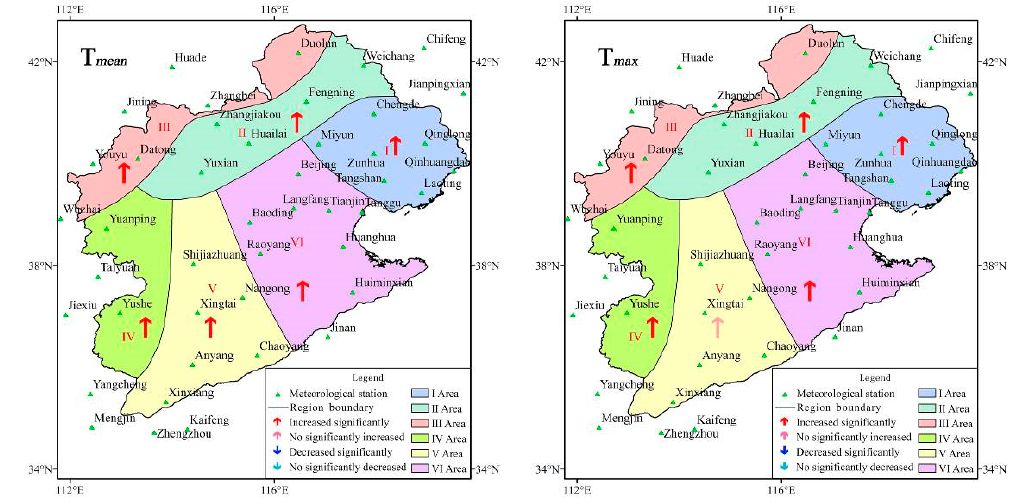
Table 2. Grading table of Spearman correlation coefficient ( ρ ).